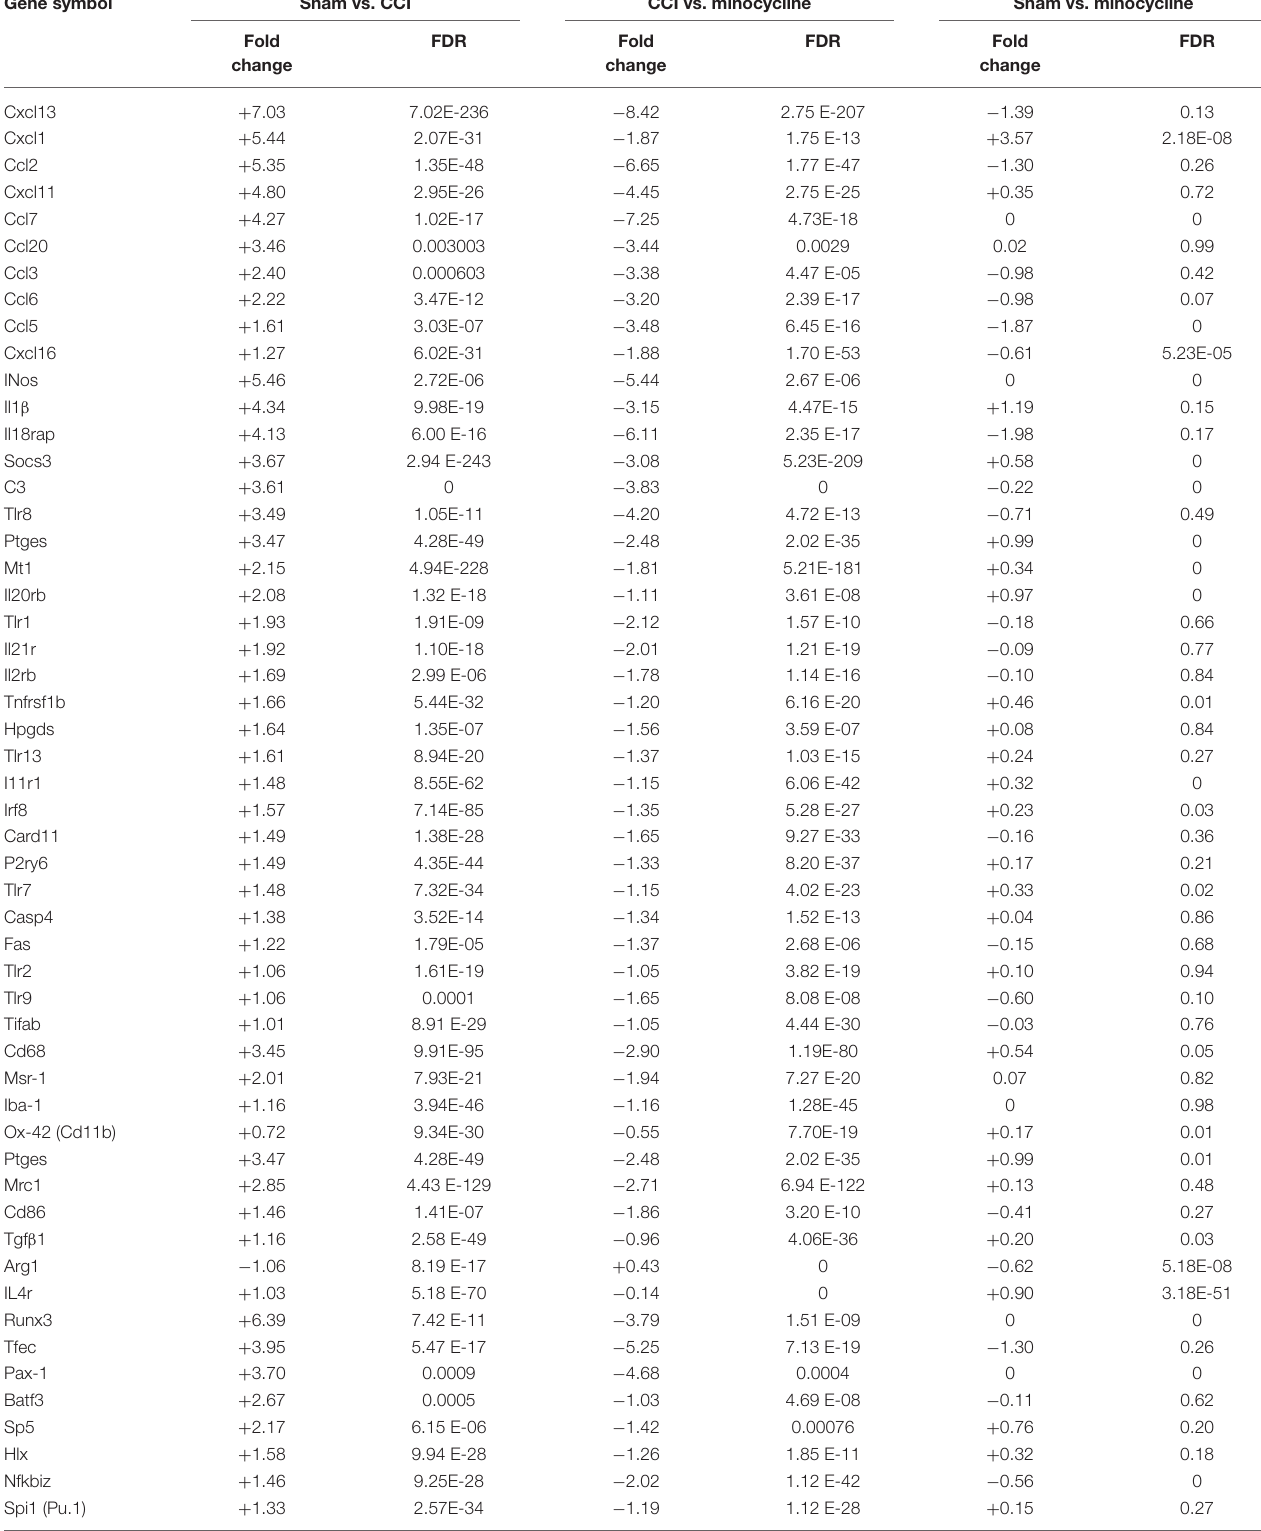
TABLE 3 | mRNA expression profile of inflammation-related genes among different groups. Gene symbol Sham vs. CCI CCI vs. minocycline Sham vs. minocycline Fold FDR Fold change